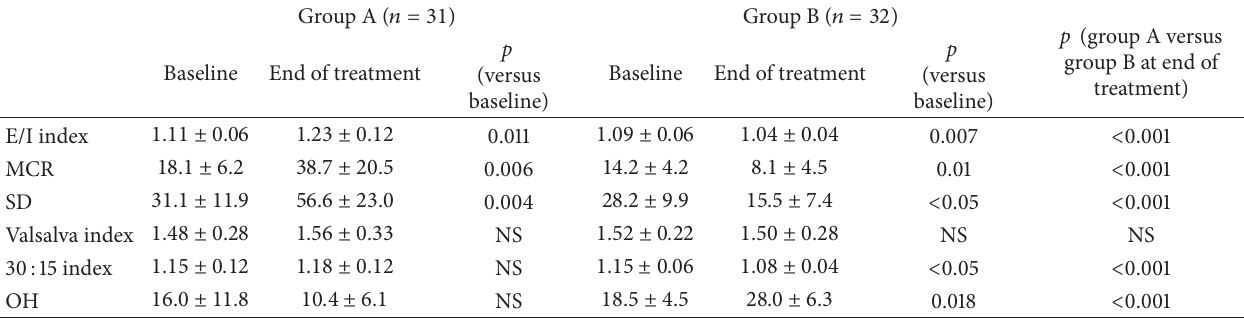
p (group A versus group B at end of